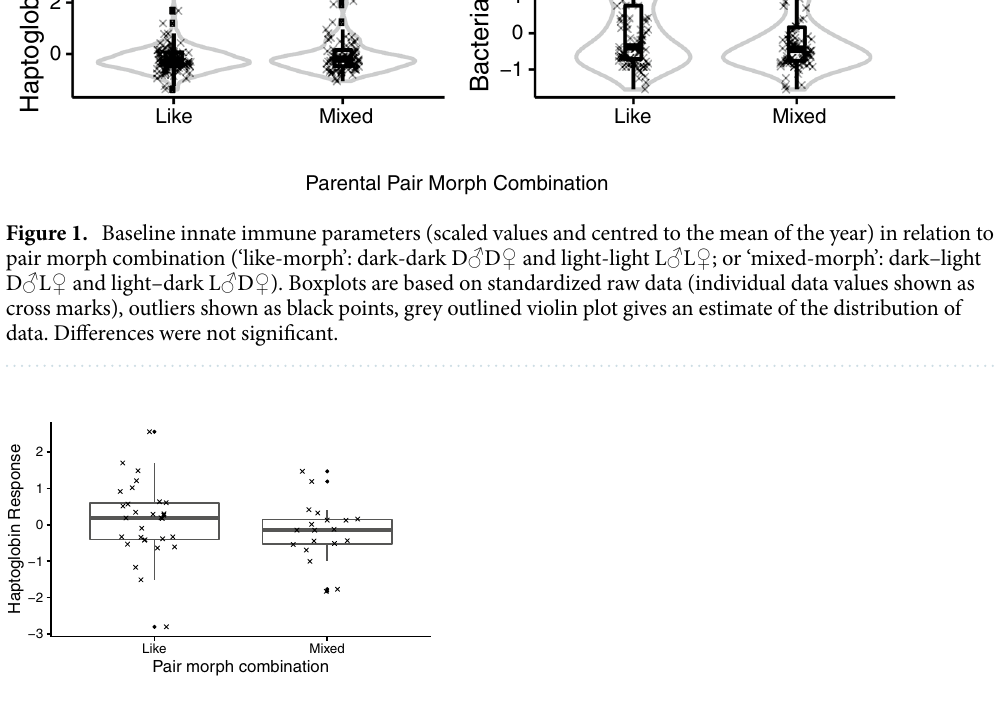
Figure 2. Haptoglobin response (scaled values and centred to the mean of the year) in relation to pair morph combination (‘like-morph’: dark-dark D ♂ D ♀ and light-light L ♂ L ♀ ; or ‘mixed-morph’: dark–light D ♂ L ♀ and light–dark L ♂ D ♀ ). The haptoglobin response variable is the difference in haptoglobin concentration between the baseline haptoglobin and the concentration measured after the injection of lipopolysaccharides (LPS). Cross marks are scaled raw values, black dots outliers. All values scaled and centred to the mean of the collection year to remove between-year variation. Differences were not